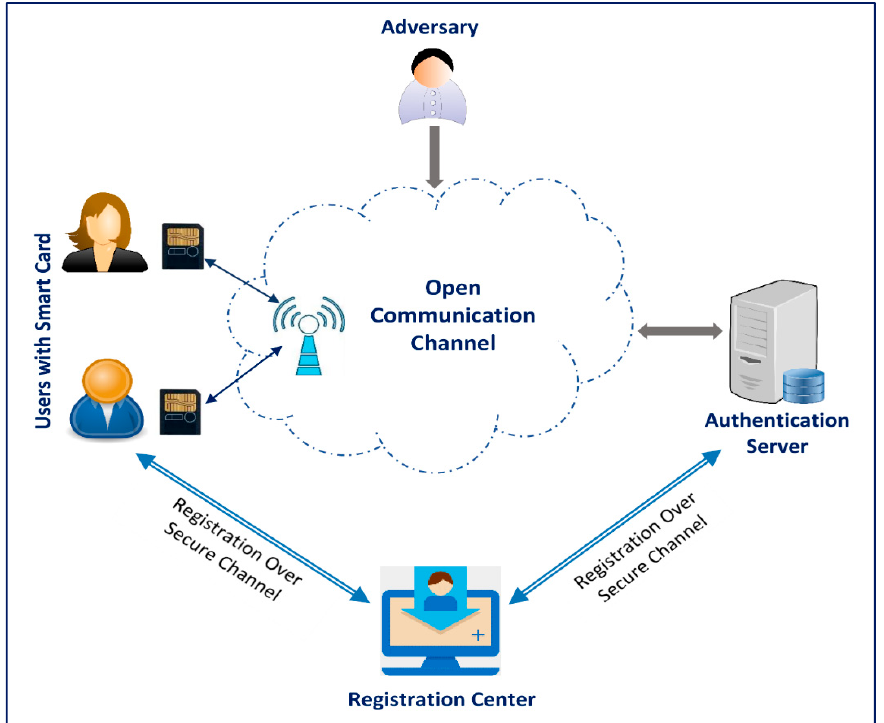
Figure 3. Communication model.